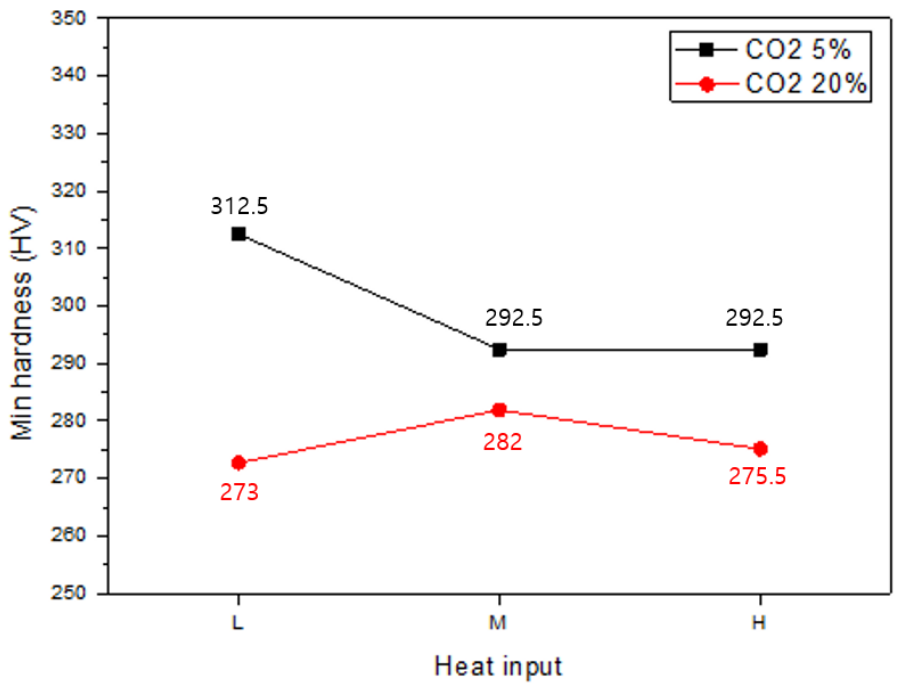
Figure 9. Minimum hardness analyses of GMAW with CO 2 5% and 20% shielding gas and heat input in weldment.